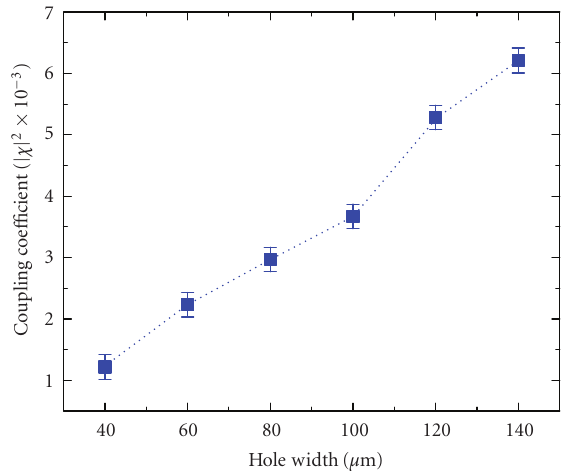
Figure 9: Calculated coupling coe ffi cient of the Al-Si SP [ ± 1,0] modes with nonresonant transmission for di ff erent hole widths at normal incidence. The dotted line is a guide to the